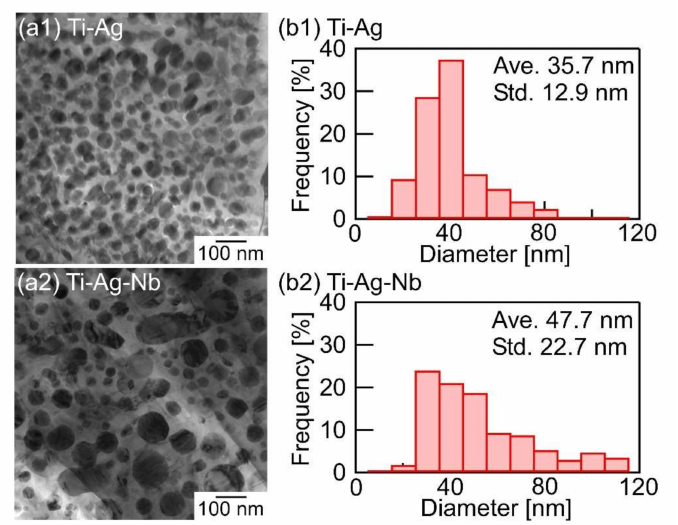
Figure 9. TEM-BF images and the size distribution of the globules in the rapidly-solidified melt-spun ribbons in Ti 53.4 Ag 33.3 Nb 13.3 , together with those of the binary Ti 66.7 Ag 33.3 alloy as a reference. ( a ) TEM-BF images, ( b ) the size distribution of the globules. ( a1 , b1 ) Ti 66.7 Ag 33.3 alloy, ( a2 , b2 ) Ti 53.4 Ag 33.3 Nb 13.3 alloy. The denotations of Ave. and Std. refer to the average size and the standard deviation of the size of globules,